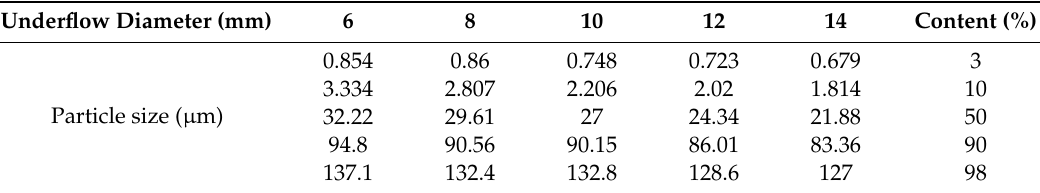
Table 5. Particle size of I underflow.